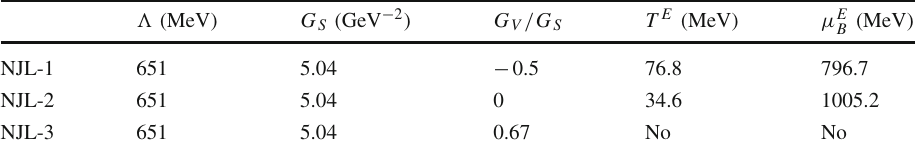
Table 1 Three sets of parameters used in the NJL model, and the corresponding critical temperatures and chemical potentials at